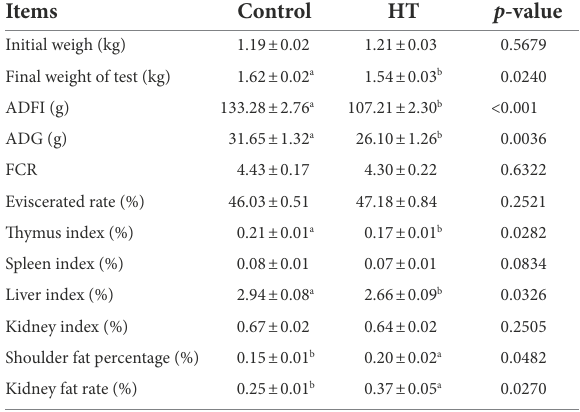
TABLE 1 Effect of heat stress on meat rabbit’s carcass